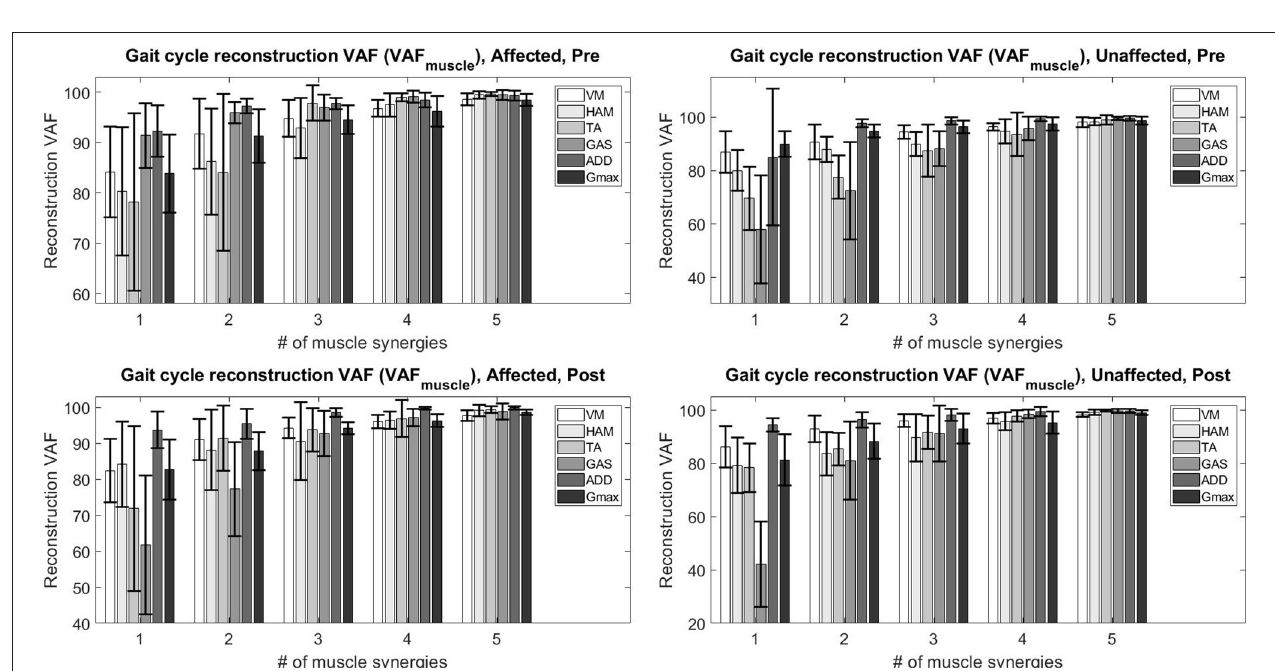
FIGURE 3 | Total variability accounted for (VAF muscle ) based on the number of muscle synergies and